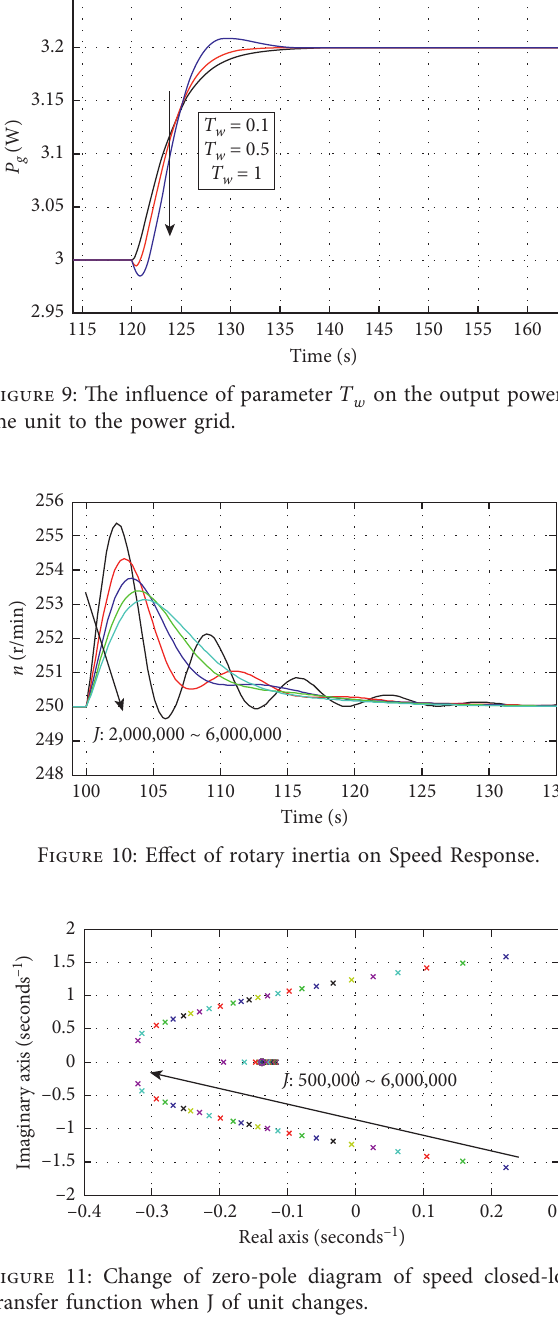
Figure 11: Change of zero-pole diagram of speed closed-loop transfer function when J of unit